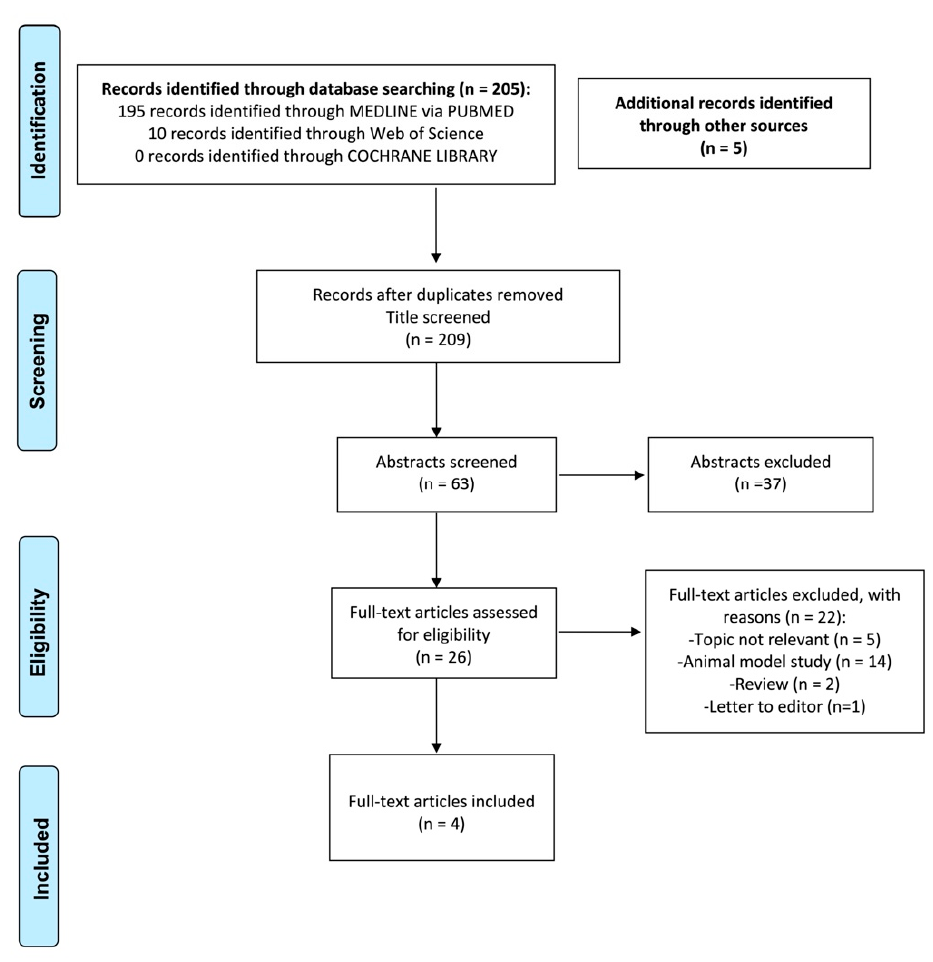
Figure 1. Flow chart of the search followed the guidance of PRISMA recommendations.